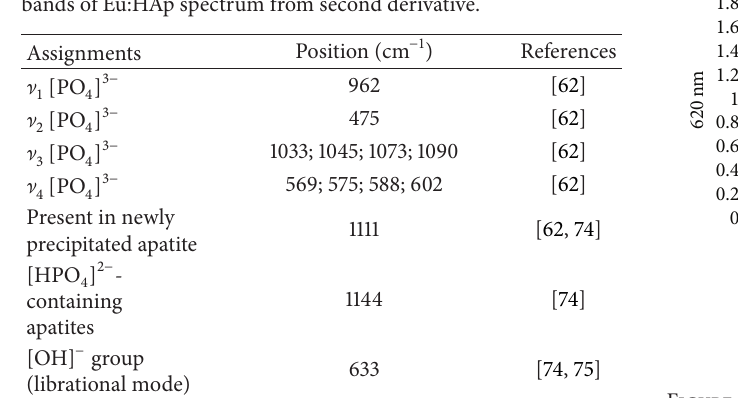
Figure 4: Antimicrobial activity of as-prepared Eu:HAp samples = 0.05 ) on E. coli ATCC 25922 , Pseudomonas aeruginosa 1397, ( 𝑥 Eu Staphylococcus aureus 0364, Enterococcus faecalis ATCC 29212, and Candida albicans ATCC